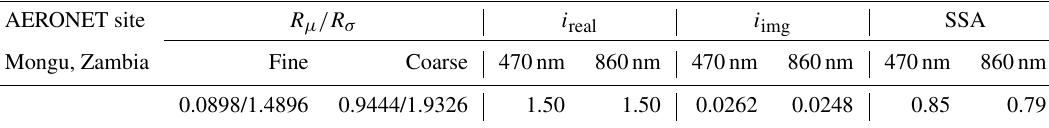
Table 2. Aerosol microphysical–optical properties of the carbonaceous smoke model and radiative transfer configurations assumed in the radiative transfer simulations.